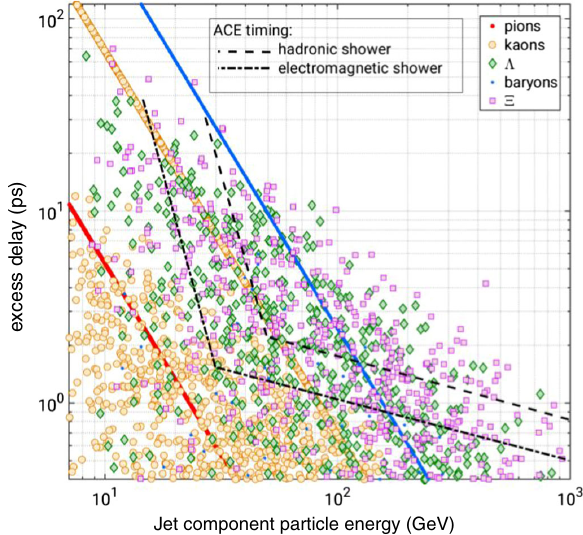
FIG. 35. TOF simulation for 100 TeV PYTHIA 8 -simulated jet components with symbols denoting the particle type in each case, including the decays of the shorter-lived mesons and hyperons. The dashed and dot-dash lines provide lower bounds on the regions over which ACE can provide picosecond timing for either electromagnetic or hadronic showers for particles to the right and above the given lines. Quasistable particles appear to stack closely along diagonal lines corresponding to their